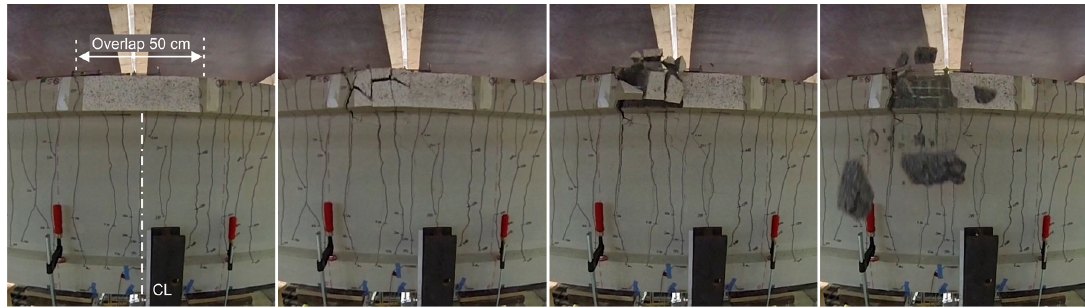
Figure 10. Failure sequence of FT03 in the overlap section in mid ‐ span ( Δ t = 0.32 s).